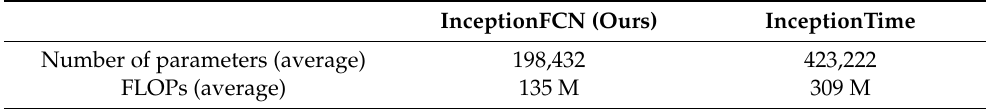
Table 3. Average FLOPs comparison (in